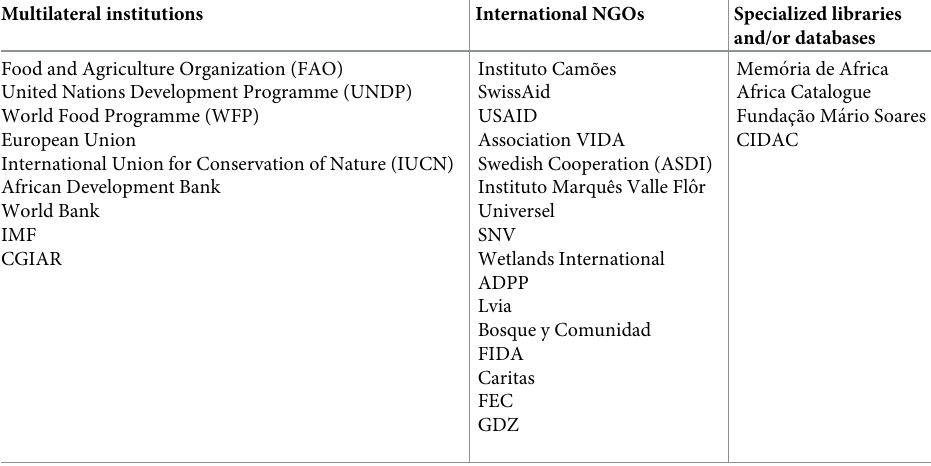
Table 2. List of institutions and specialized